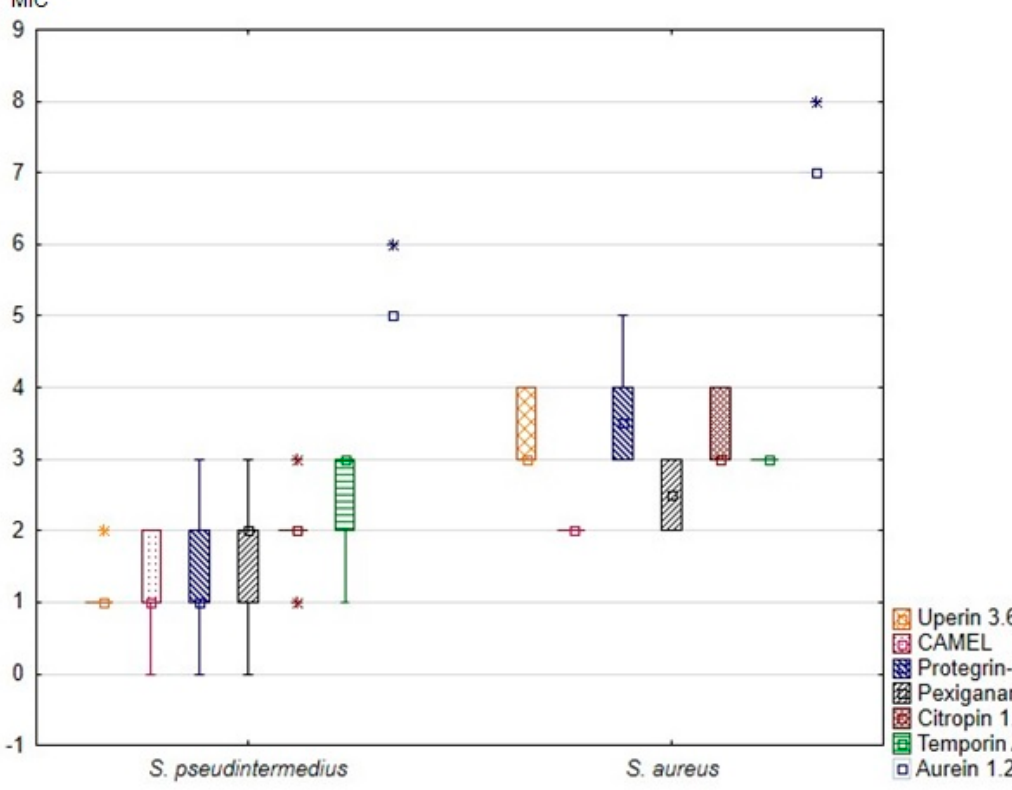
Figure 1. Minimal inhibitory concentrations (MIC) of the tested antimicrobial peptides against canine S. pseudintermedius and S. aureus strains. The results are presented as medians (points), interquartile ranges (boxes), ranges (whiskers) and outliers (asterisks). Minimal inhibitory concentrations on the Y axis are shown as log2(x).